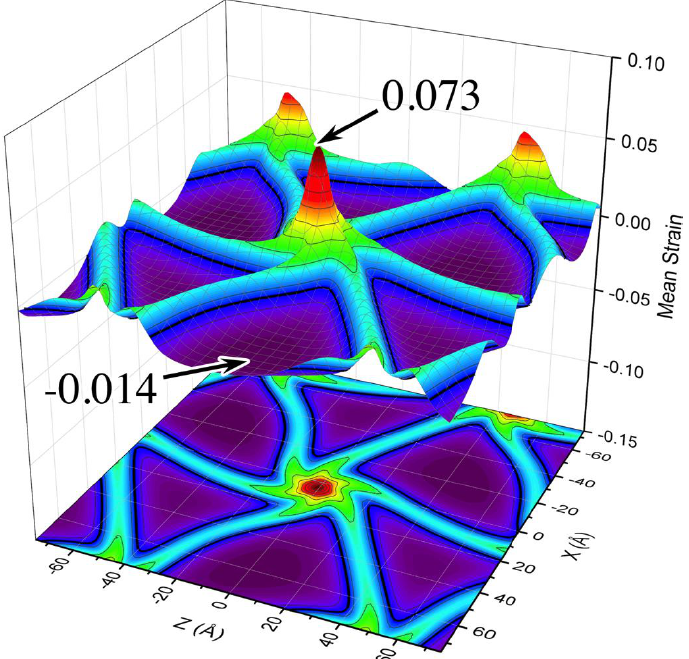
Figure 2. The contour surface plot of the two-dimensional ( x – z ) mean strain on the Cu side of the interface. The black lines denote the contour level with zero mean